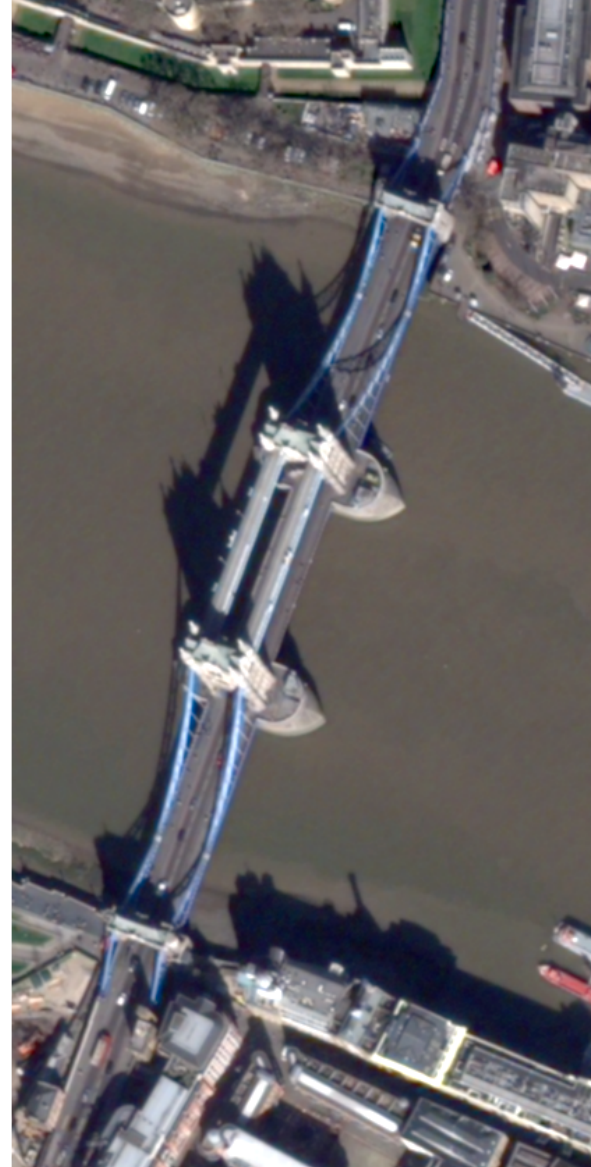
Figure 4 : MS image pan-sharpened using Gram-Schmidt pan- sharpening in Esri’s ArcGIS for Desktop